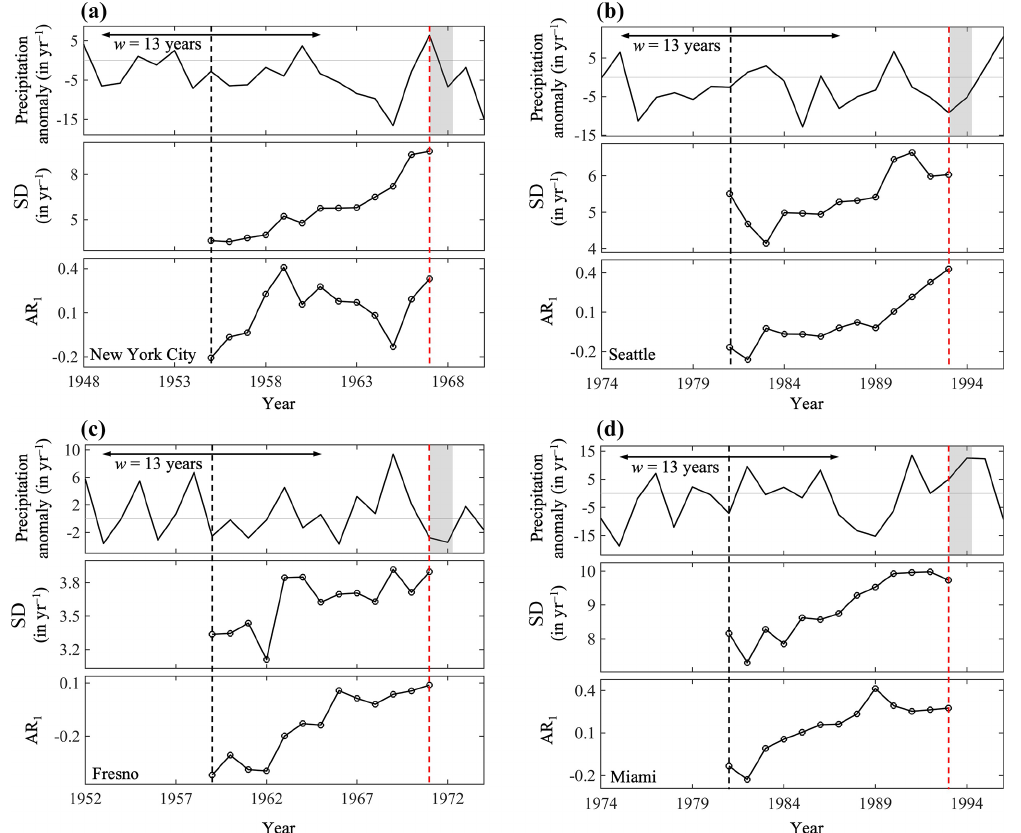
Figure 3. Time series of anomalies, AR 1 , and SD of precipitation in (a) New York, (b) Seattle, (c) Fresno, and (d) Miami in the CONUS. The horizontal lines with arrows show the width of one moving window (13 years), the vertical dashed red lines represent critical transitions, and the gray bands represent the transition phase. Table 1. The division of CONUS cities into nine geographical regions. Number Region